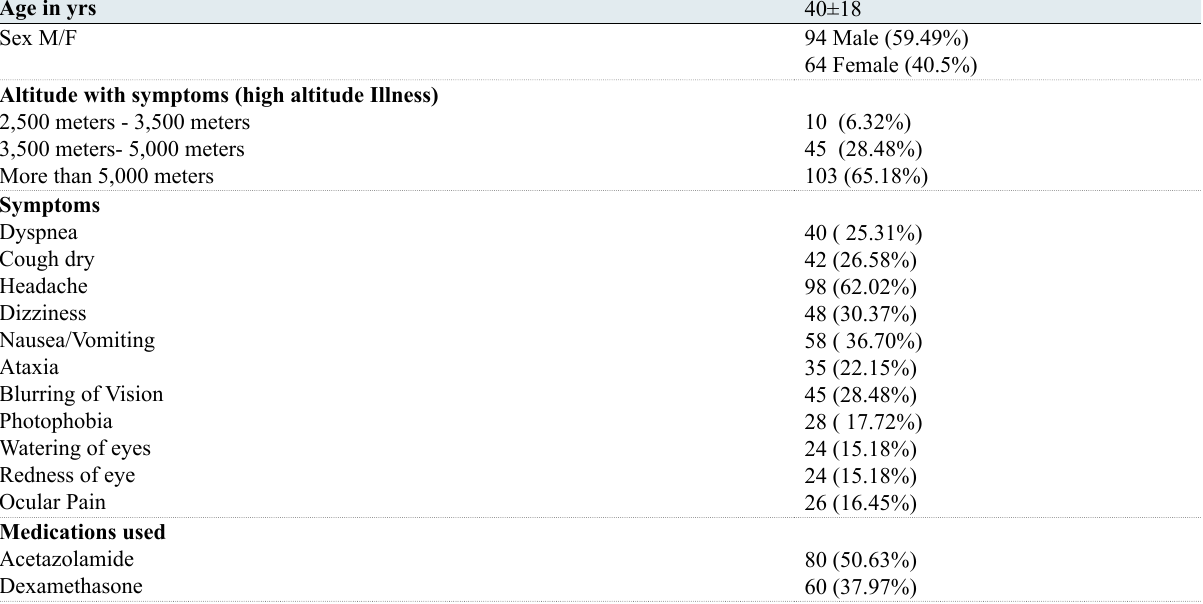
Table 1 : Baseline characteristics of patient with high altitude sickness ( n=158